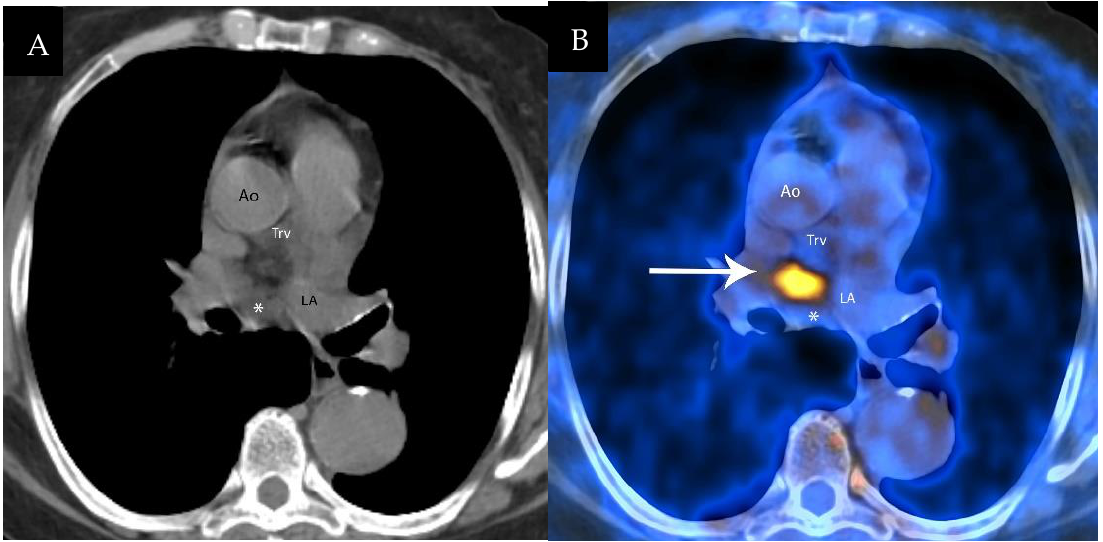
Figure 10. Hypermetabolic brown fat mimicking nodal metastasis. 69 year-old woman with esophageal cancer. ( A ). Staging fused axial PET/CT shows FDG avid focus (arrow) in the mediastinum mimicking nodal metastasis. ( B ). CT with and without intravenous contrast localized the FDG activity to pericardial fat between the fluid in the transverse sinus (Trv) posterior to the aorta (Ao) and the oblique sinus (asterisk) posterior and superior to the left atrium (LA). Physiologic uptake due to hypermetabolic brown fat is a potential pitfall in PET/CT interpretation. Reprinted from Shroff G.S. et al. Pitfalls in oncologic imaging of the pericardium on CT and PET/CT [4].